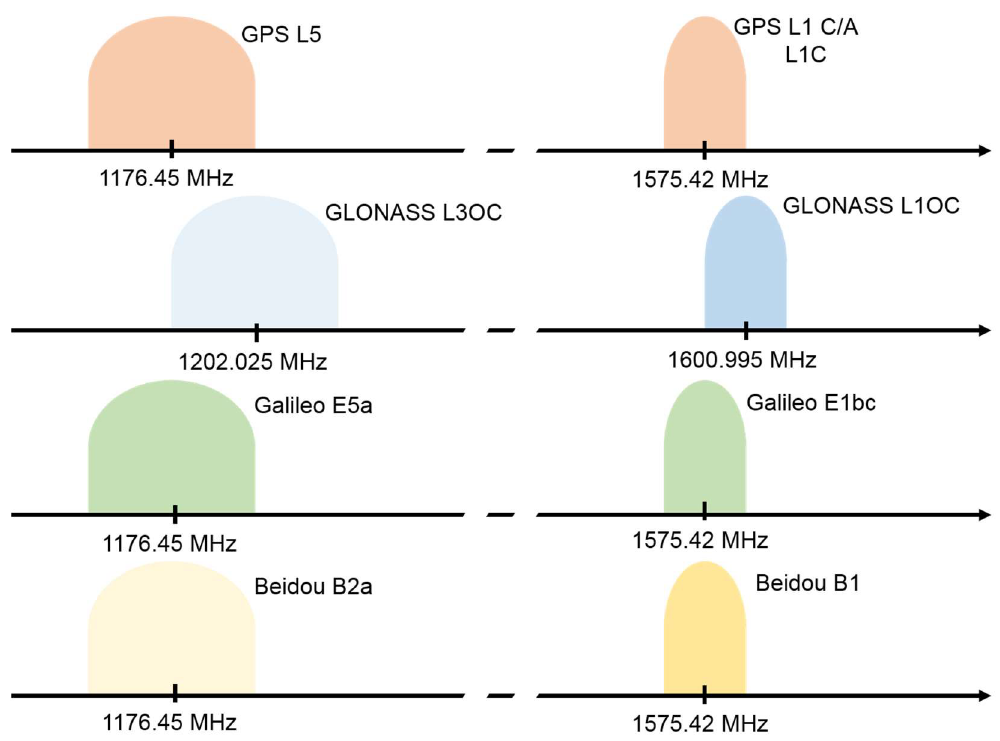
Figure 1. Global Navigation Satellite System (GNSS) signal structures considering only bands around GPS L1 and L5 frequencies, which were used in these tests.